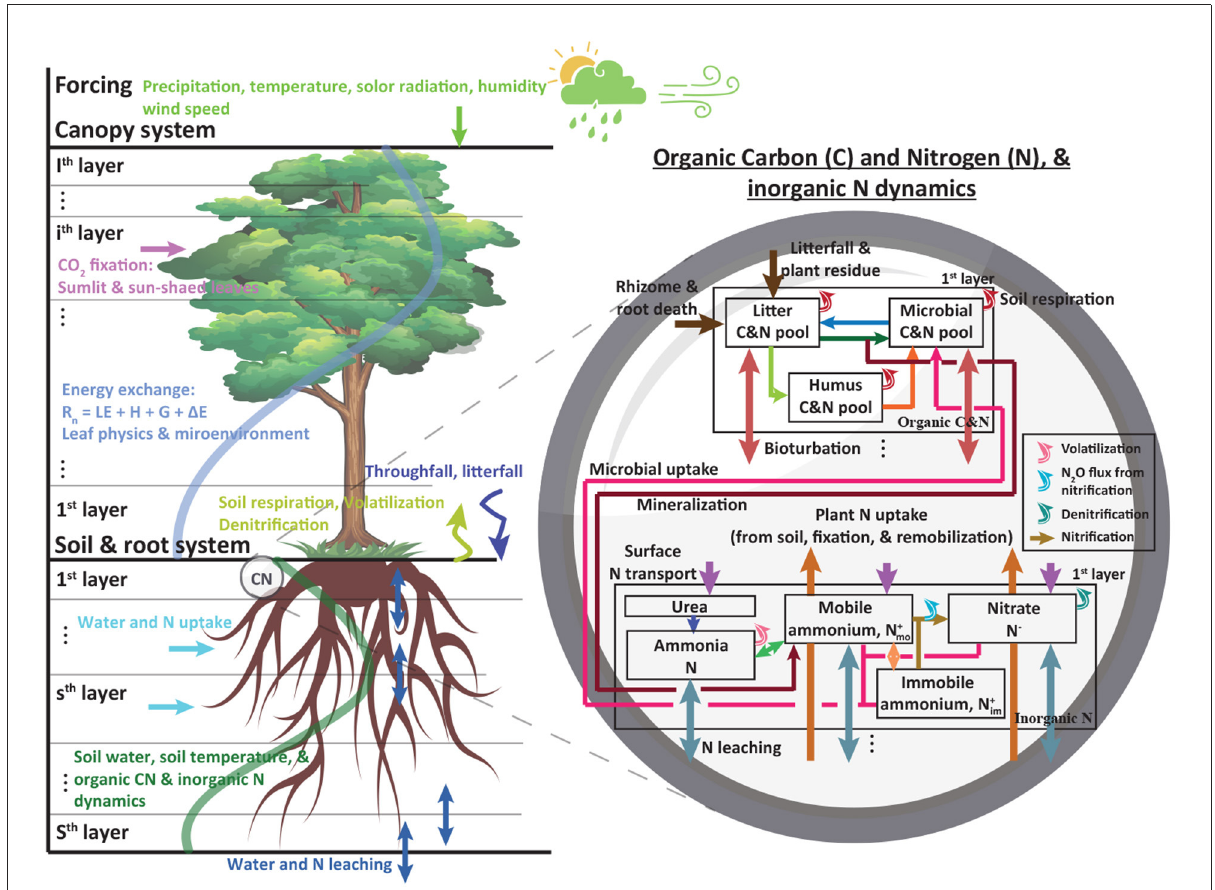
FIGURE1 A schematic diagram showing a coupled MLCan (left) and biogeochemical (right) model for the first soil layer. Multiple canopy and soil layers were implemented. Layers not shown in the right panel follow the first layer approach except for litterfall and surface nitrogen transport which only occur in the first soil layer. Precipitation, temperature, solar radiation, humidity, and wind speed were used as forcings. Soil moisture, temperature, subsurface water flux, and water uptake estimated in MLCan, directly and indirectly, influence soil organic carbon and nitrogen, and inorganic nitrogen dynamics. More details about this model including equations and parameters can be found in previous studies (Drewry et al., 2010a,b; Woo et al., 2014; Woo and Kumar,